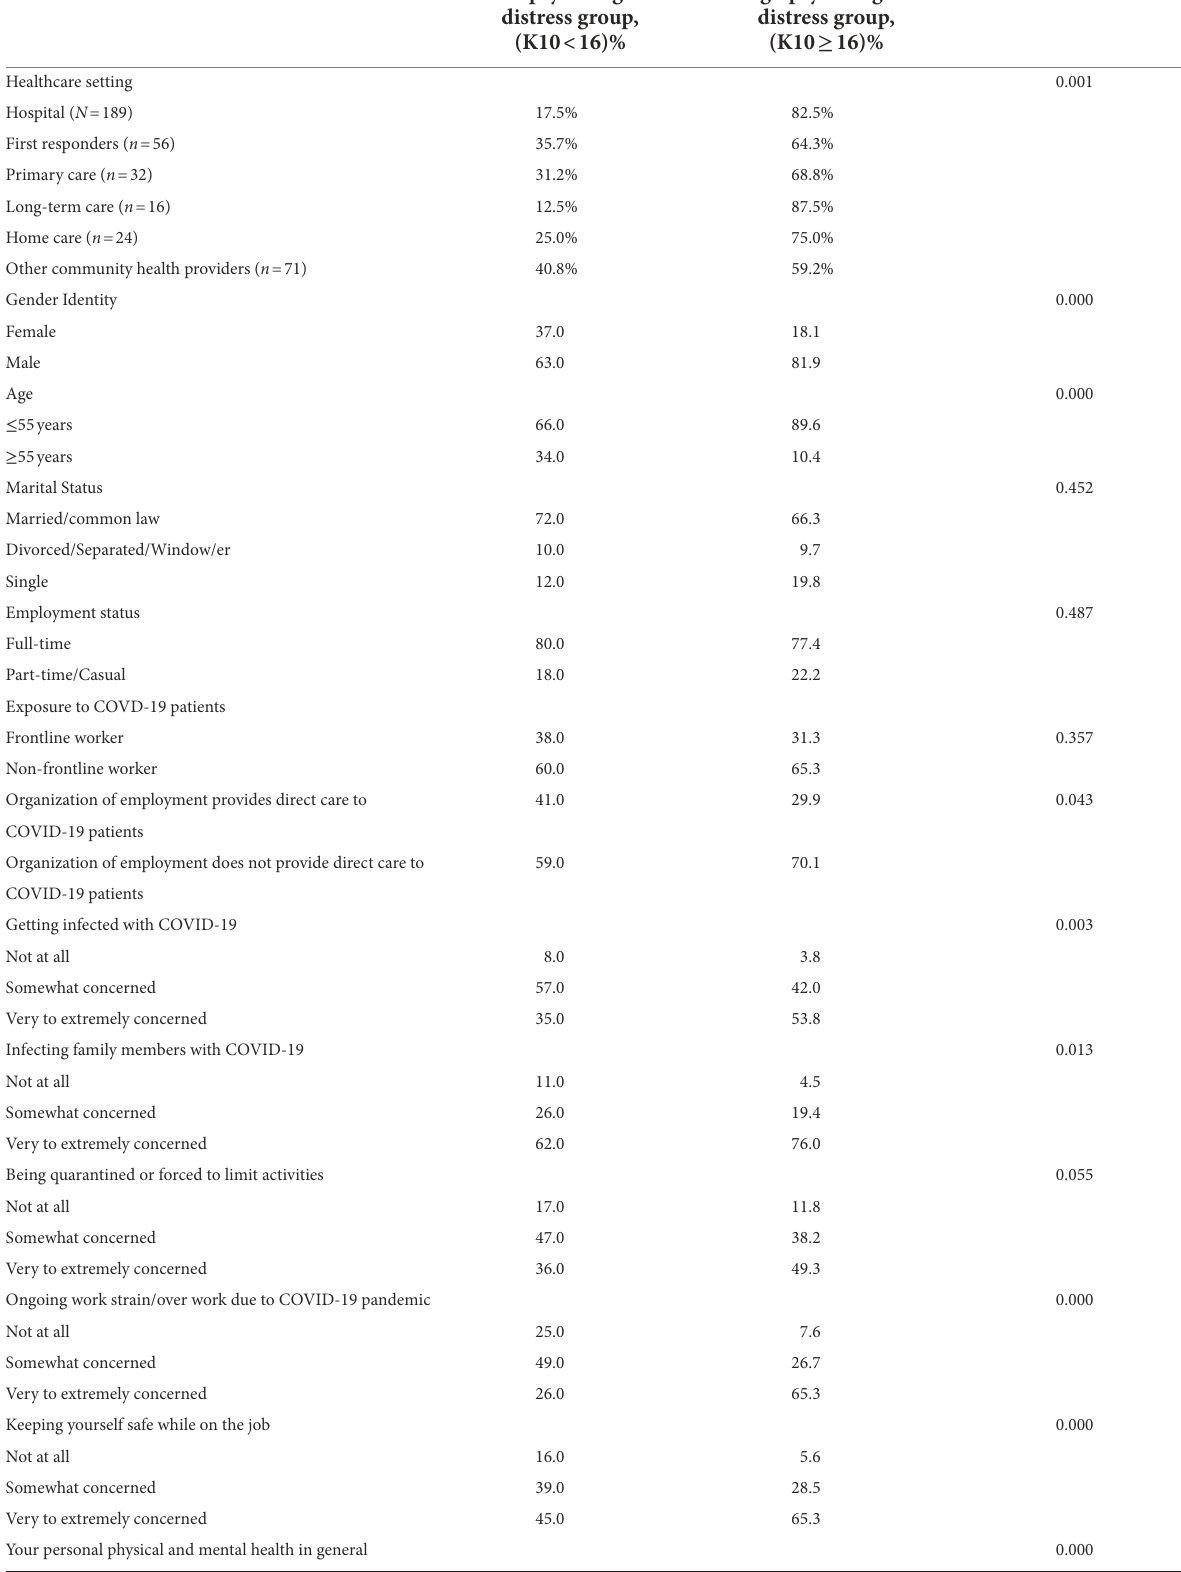
TABLE 4 Differences between low and high psychological distress groups on study variables.